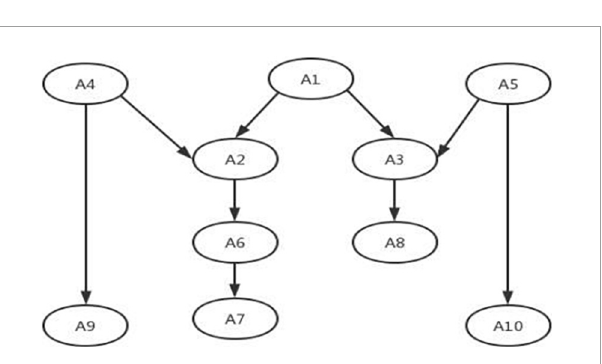
FIGURE1 Hierarchical relationship of knowledge attributes of mathematical operations.